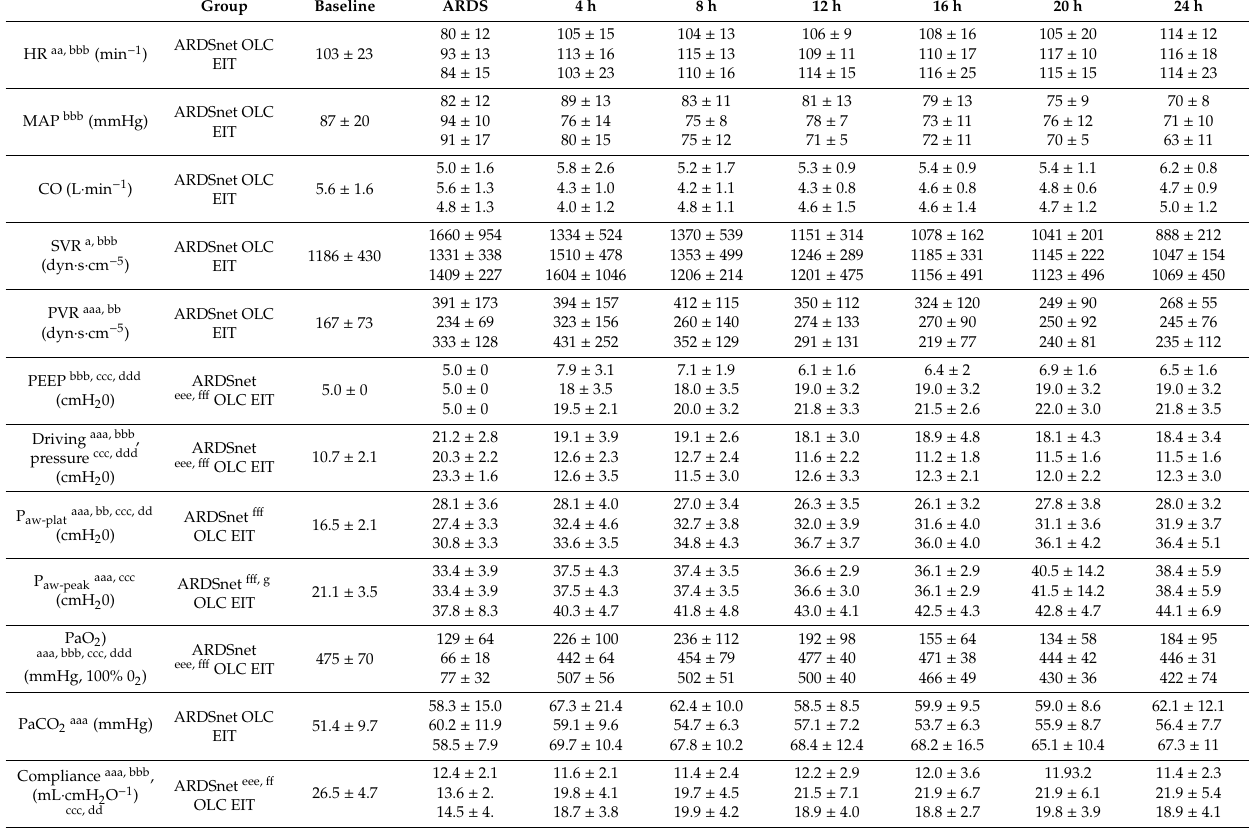
Table 1. Hemodynamic and respiratory